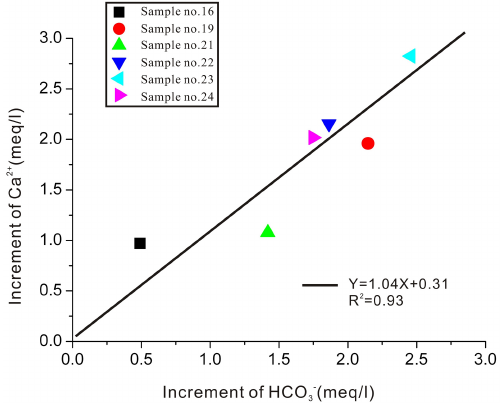
Figure 5. The plot of Ca 2 + vs. HCO − milli-equivalent, showing 3 Ca 2 + and HCO − were most probably derived from the decomposi- 3 tion of carbonates. The abscissa indicates the Ca 2 + increment of the water samples being relative to Ca 2 + concentration in 2010, and the ordinate indicates the HCO − increment of the water samples com- 3 pared to that collected in